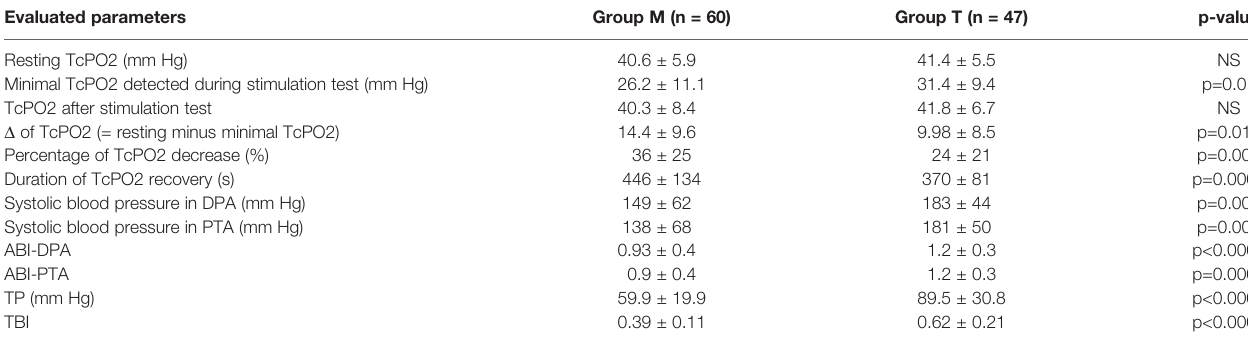
TABLE 2 | Comparison of TcPO2 parameters detected during stimulation test and large vessel parameters between study groups. Evaluated